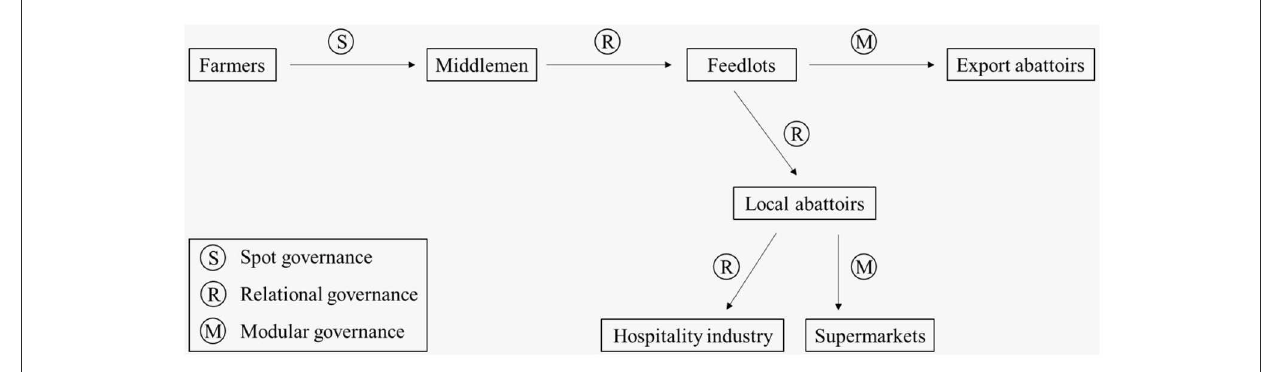
FIGURE5 Governance structures in the meat value chain in Ethiopia.